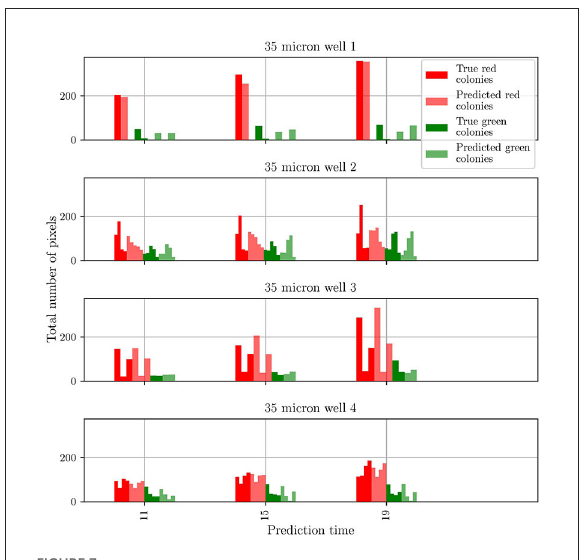
FIGURE7 Comparison of the number and size of individual colonies in the groundtruth and predicted frames for wells in the test dataset. The wells are numbered according to their position in the test